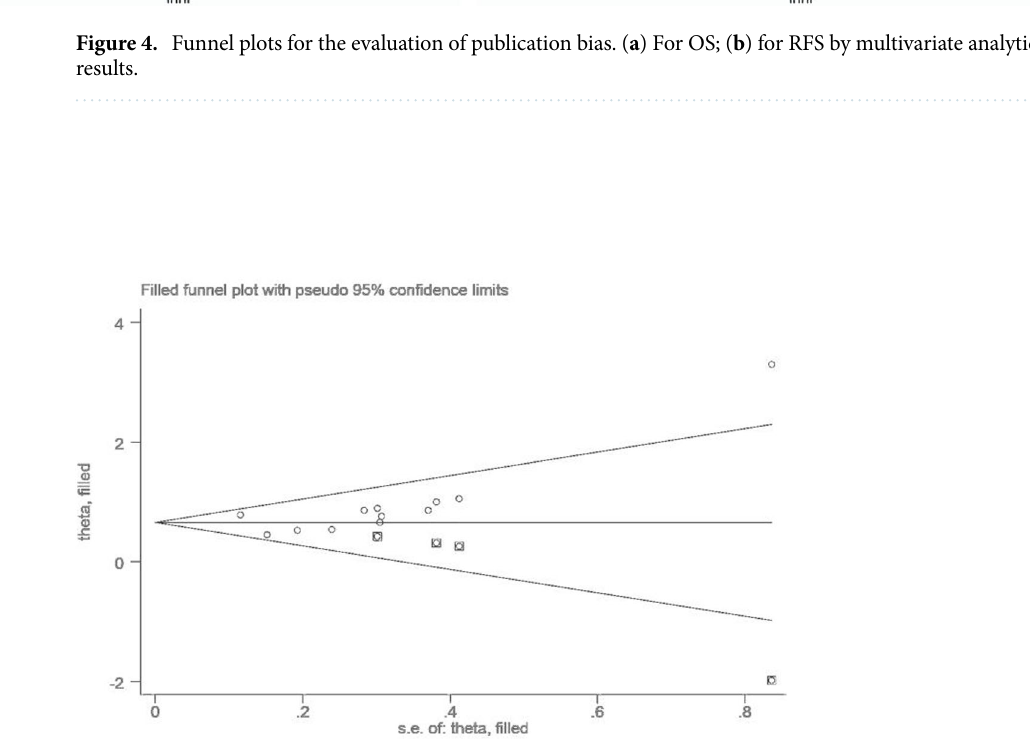
Figure 5. Funnel plot adjusted with trim-and-fill methods for